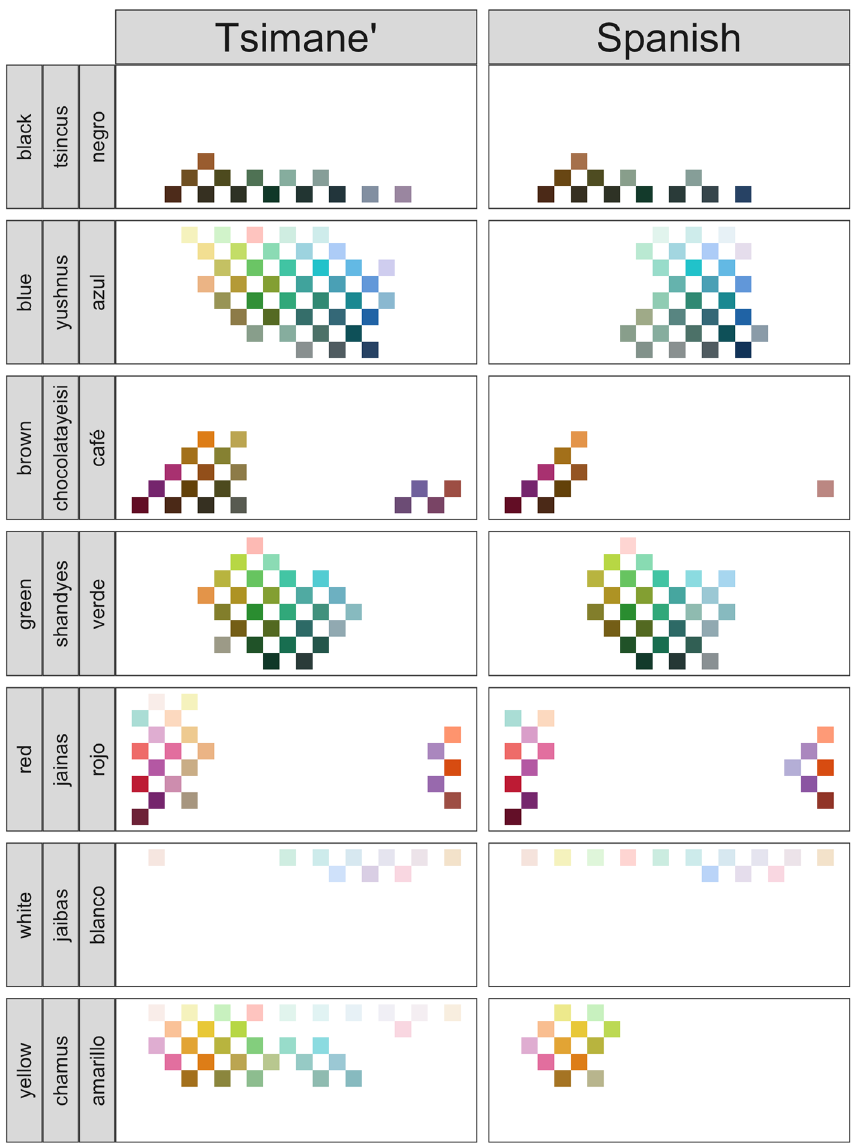
Figure 1. Representation of colors by Tsimane’–Spanish bilinguals in Tsimane’ and Spanish for seven of the eight color terms tested in the naming task. All chips colored in the graph correspond to chips chosen during the labeling task for the term indicated on the y axis. The terms were asked in the language indicated on the column label, and the most common label for that color term in Tsimane’ and Spanish (as well as the English equivalent, for presentation purposes), is given in the row labels, but see Supp. Table 2 for a full list of the existing terms in Tsimane’ for each of the colors. The eighth color term—“gray”/“chimdyes”/“gris”—was